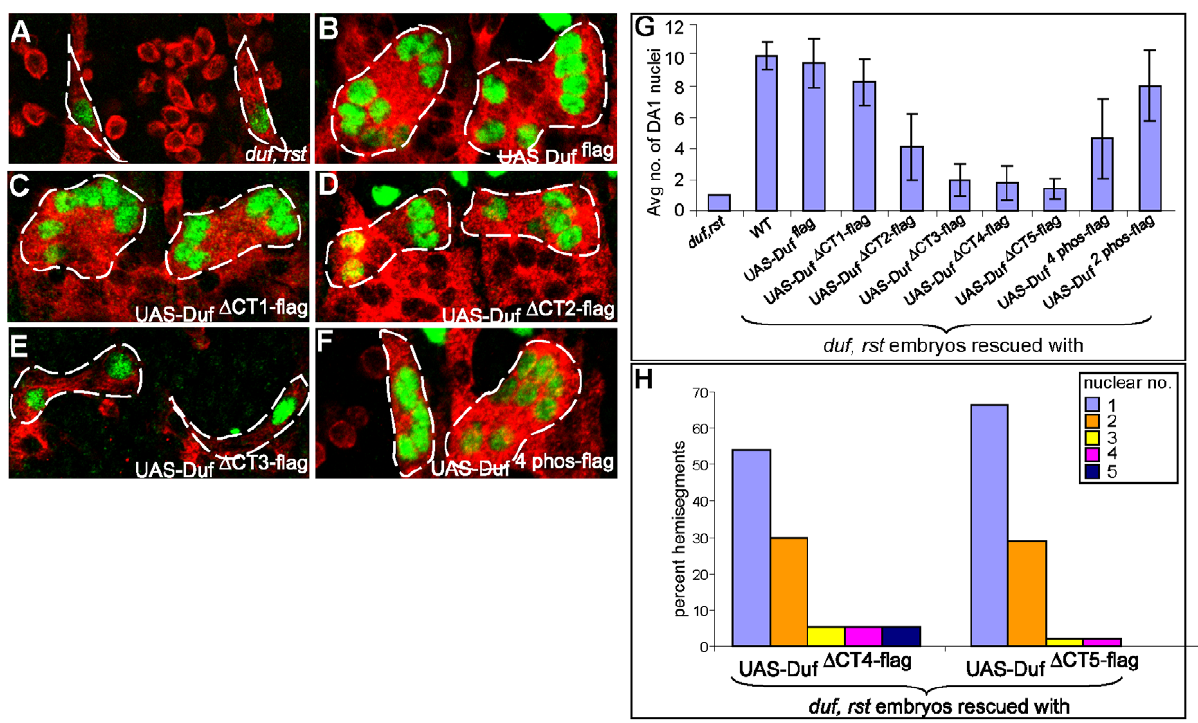
Figure 4. Regions in Duf intracellular domain function additively for efficient fusion. Late stage 15 DA1 muscles labelled with anti-MHC (red) and anti-eve (green). Fusion is completely blocked in the duf, rst mutant (A). UAS transgenic constructs driven by 24B Gal4. UAS-Duf flag (B) and UAS-Duf D CT1-flag (C) are able to rescue the duf, rst mutant. UAS- Duf D CT2-flag and UAS-Duf 4phos-flag rescue the duf, rst mutant only partially (D and F). UAS- Duf D CT3-flag is unable to rescue the duf, rst mutant beyond the initial stage of fusion. (G) Average nuclear number per DA1 muscle (40 hemisegments, A2–5, 10 embryos each) in embryos rescued with UAS-Duf flag and UAS Duf mutant constructs in comparison with wild type (WT) and the duf, rst mutant. (Students t-test P , 0.001) (H) Distribution of nuclear numbers per hemisegment in duf, rst embryos rescued with UAS-Duf D CT4-flag and UAS-Duf D CT5-flag .